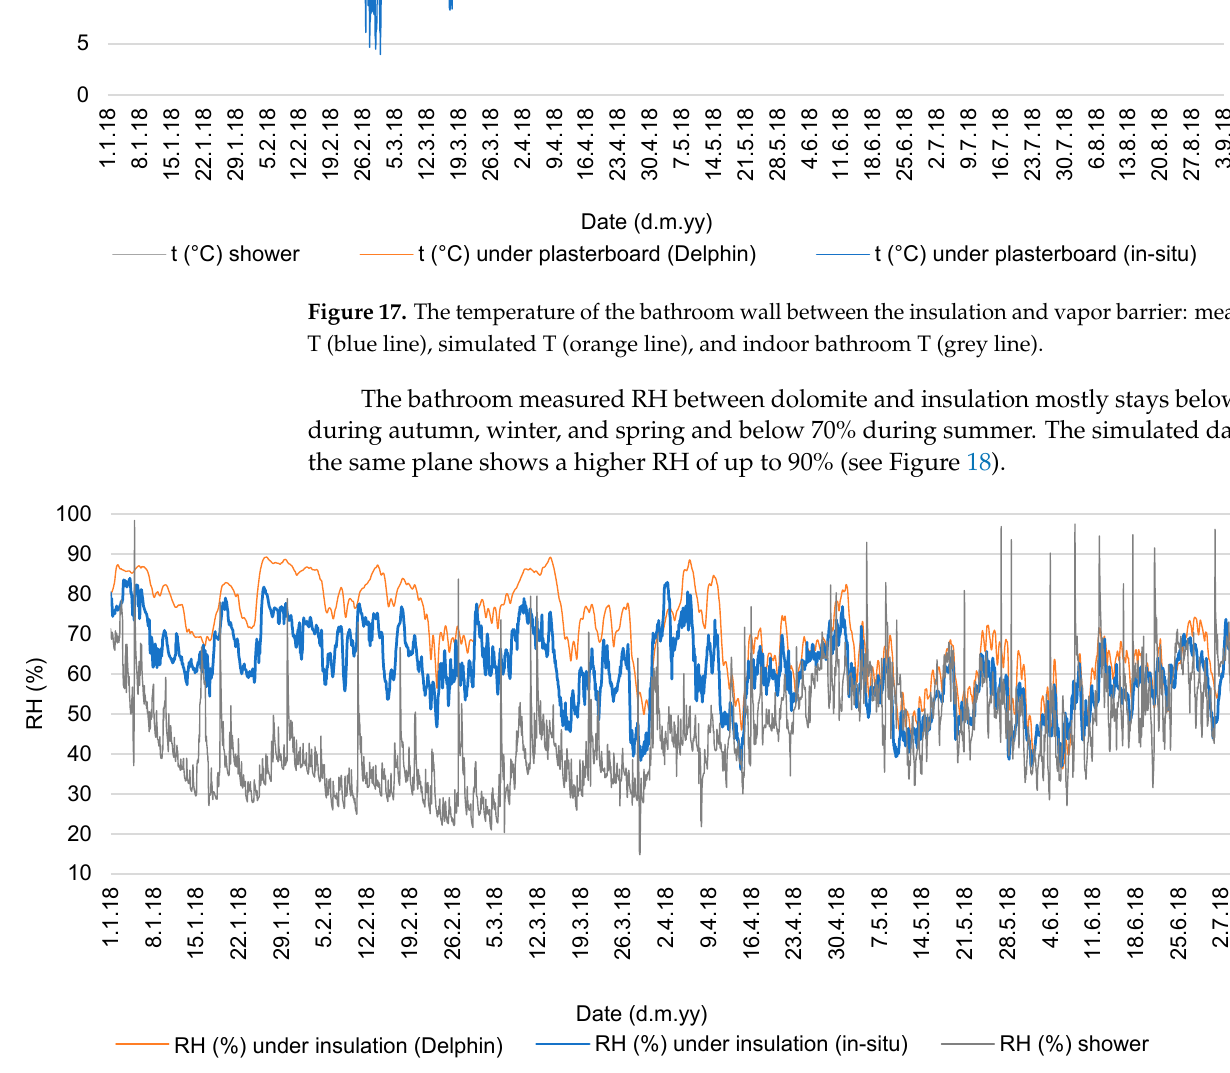
Figure 18. Relative humidity of the bathroom wall between dolomite and insulation layers: measured RH (blue line), simulated RH (orange line), indoor RH (grey line), and outdoor RH (green line). Measured temperatures between dolomite and insulation follow outside temperatures during the heating season and are between outdoor and indoor temperatures outside the heating season (see Figure 19).